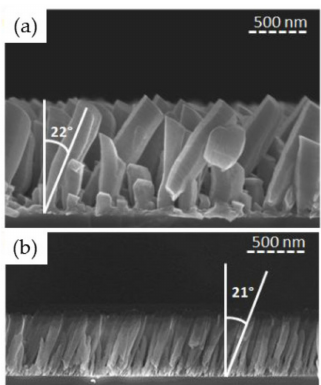
Figure 15. Cross-sectional SEM images of nano-columnar ( a ) Mg and ( b ) MgO thin film deposited at 50 W, 0.26 Pa, and α = 85 ◦ . The white angle accounts for the average columnar tilt angle ( β ) estimated by over 20 columns.